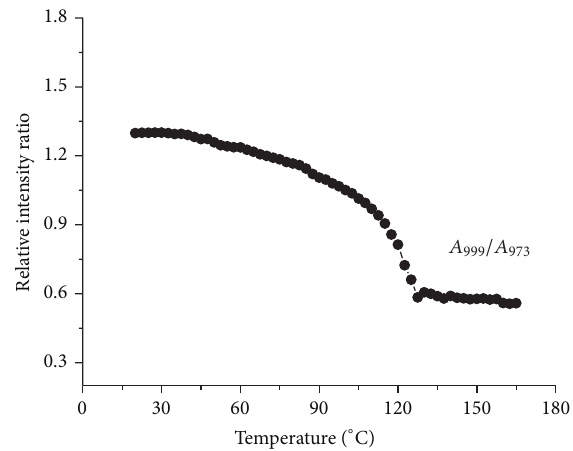
Figure 12: The relation between intensity ratio ( 𝐴 999 /𝐴 973 ) and